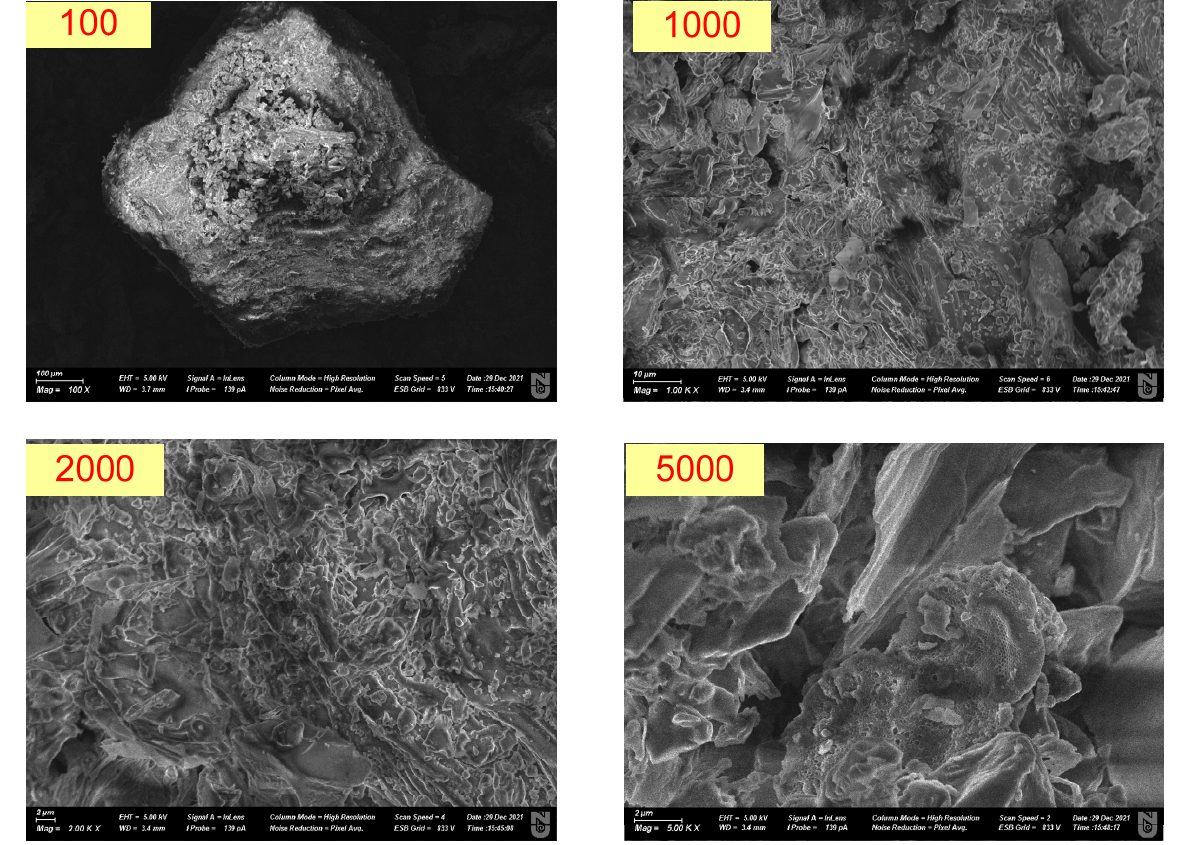
Figure 3. SEM images at different magnifications ×100, ×1000, ×2000 and ×5000 of the okra. FTIR spectra were used for the chemical composition to assess the structure of the dried okra, as depicted in Figure 4. A broadband between 4000–400 cm − 1 was measured. The sharp peak at 3282 cm − 1 is centered between (3400–3000) cm − 1 , reflecting the pres- ence of stretched hydroxyl O–H groups. The peak at 2920 cm − 1 is typical of C–H bonds resulting from vibration and represents cellulose [35]. The peak at 1735 cm − 1 is centered between (1720–1740) cm − 1 and is attributed to the ester carbonyl (COOR) groups. At the peak of 1617 cm − 1 , the carboxylate ion stretching band (COO–) appeared. The peak of 1401 cm − 1 represents hemicellulose. The polysaccharide is confirmed by the peaks be- tween (1200–900) cm − 1 . The sharp peak at 1031 cm − 1 represents the CO and OH stretch- ing vibration. This typically refers to the polysaccharide in cellulose. Additionally, cyclic alcohol is present in the natural polymer. There is also an appearance of the halo com- pound C-l at 523 cm − 1 . The FTIR confirmed that the solution contains a substantial amount of polysaccharides. Despite this confirmation, the peaks’ study range is slightly different from the previous studies on Chinese and Malaysian okra [35,36].